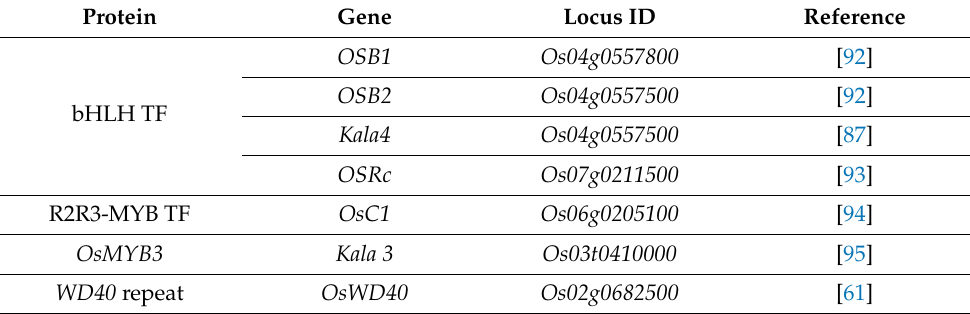
Table 6. Anthocyanin production regulatory genes in rice. Protein Gene Locus